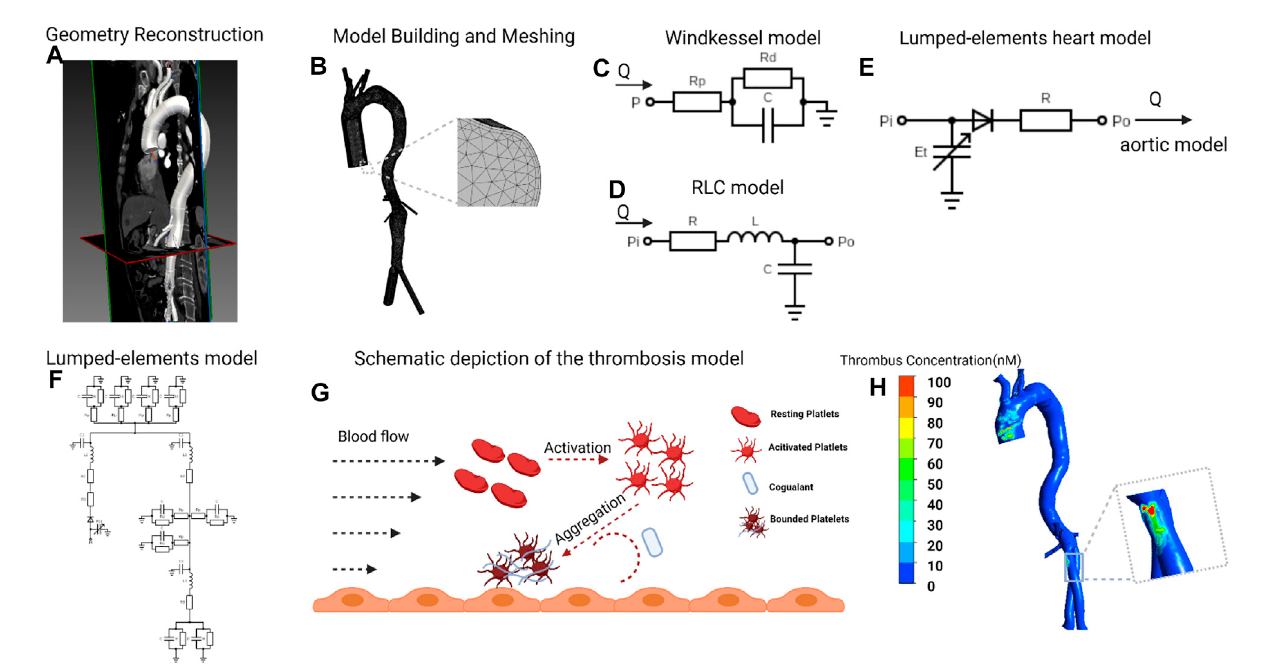
FIGURE 1 Flowchart of patient-speci fi c modeling (A) , Geometry of postoperative aorta was modeled from CTA data, starting from the ascending aorta to bilateral common iliac arteries. (B) , Meshing the model and vessel outlets were suf fi ciently extended to allow fully developed fl ow boundary. (C,D) , Building the Windkessel model, lumped-parameter aortic model based on the clinical measured blood fl ow pressure and velocity. (E) , The lumped-elements model representing the heart was coupled to the entrance node in the lumped-elements aortic model. (F) , Coupling the three kinds of lumped-parameter model to give out the aortic blood fl ow velocity in different heart functions. (G) , The simulation of thrombosis formation involving the activation of resting platelets (RPs), the deposition of coagulant (C) and the aggregation of activated platelets (APs) to form the bounded platelets (BPs). ( H) , Thrombus concentration pro fi le of one patient. CTA, computed tomography angiography. The fi gure was created with